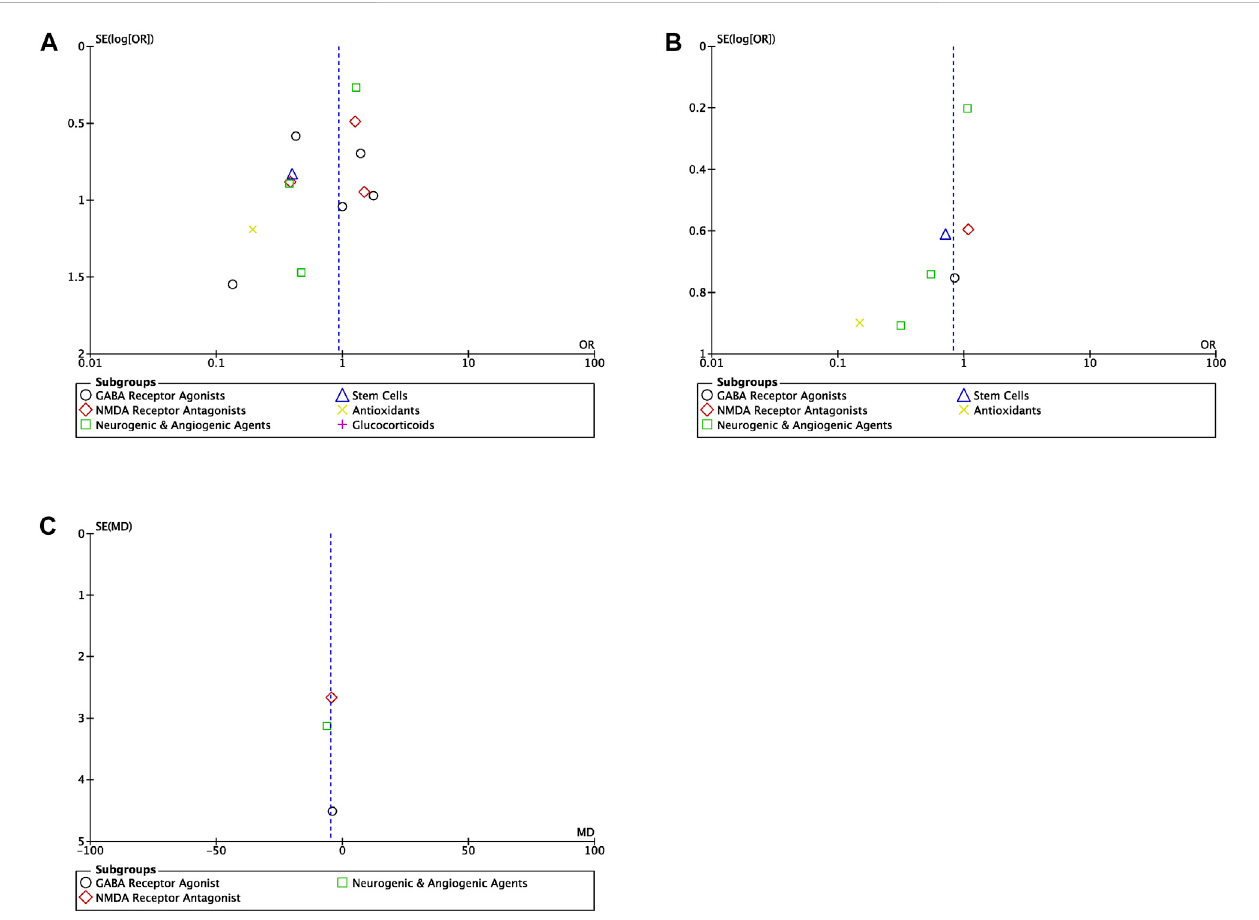
Funnel plots (A) Funnelplotfor thestudies reporting mortalityfor alldrug classes(OR, oddsratio) (B) Funnel plotfor thestudiesreporting NDI forall drug classes (OR, odds ratio) (C) Funnel plot for the studies reporting length of hospitalization for all drug classes (MD, mean